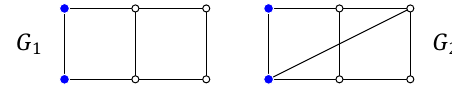
Figure 1: The filled vertices are a zero forcing set in G 1 but not in G 2